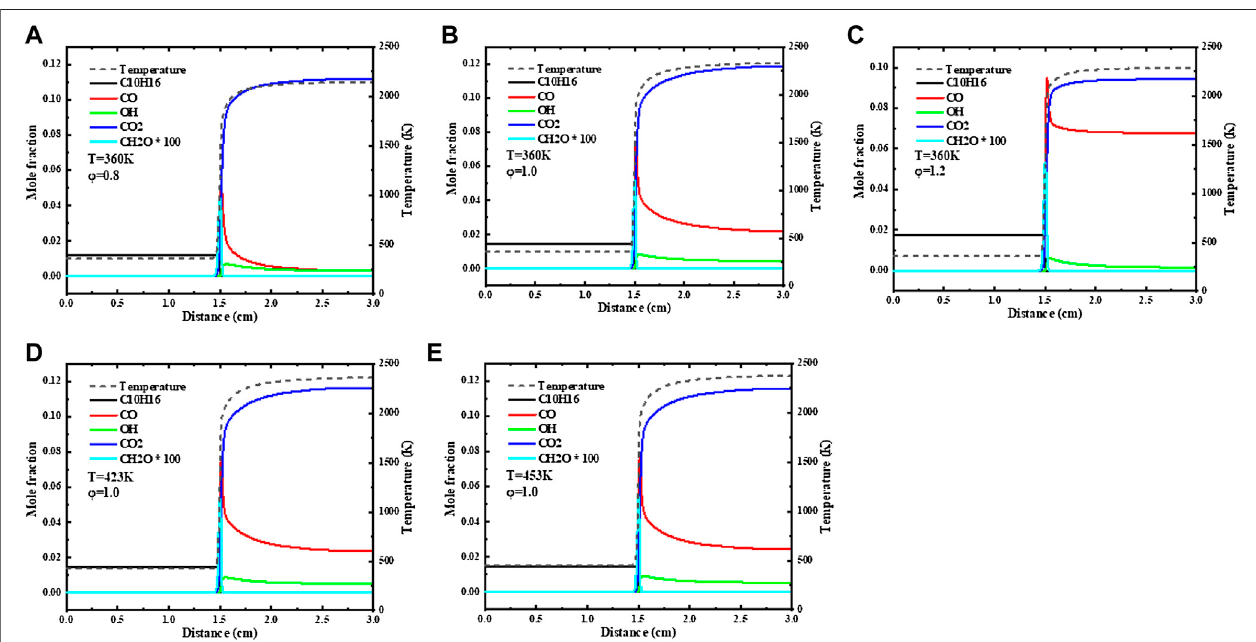
FIGURE7| Majorspeciesmolefractionandadiabatic fl ametemperatureofJP-10/air fl ameofT=360 K, (A) φ =0.8, (B) 1.0, (C) 1.2;and φ =1.0,T= (D) 423 K, (E) 453 K calculated with Hychem detailed mechanism.